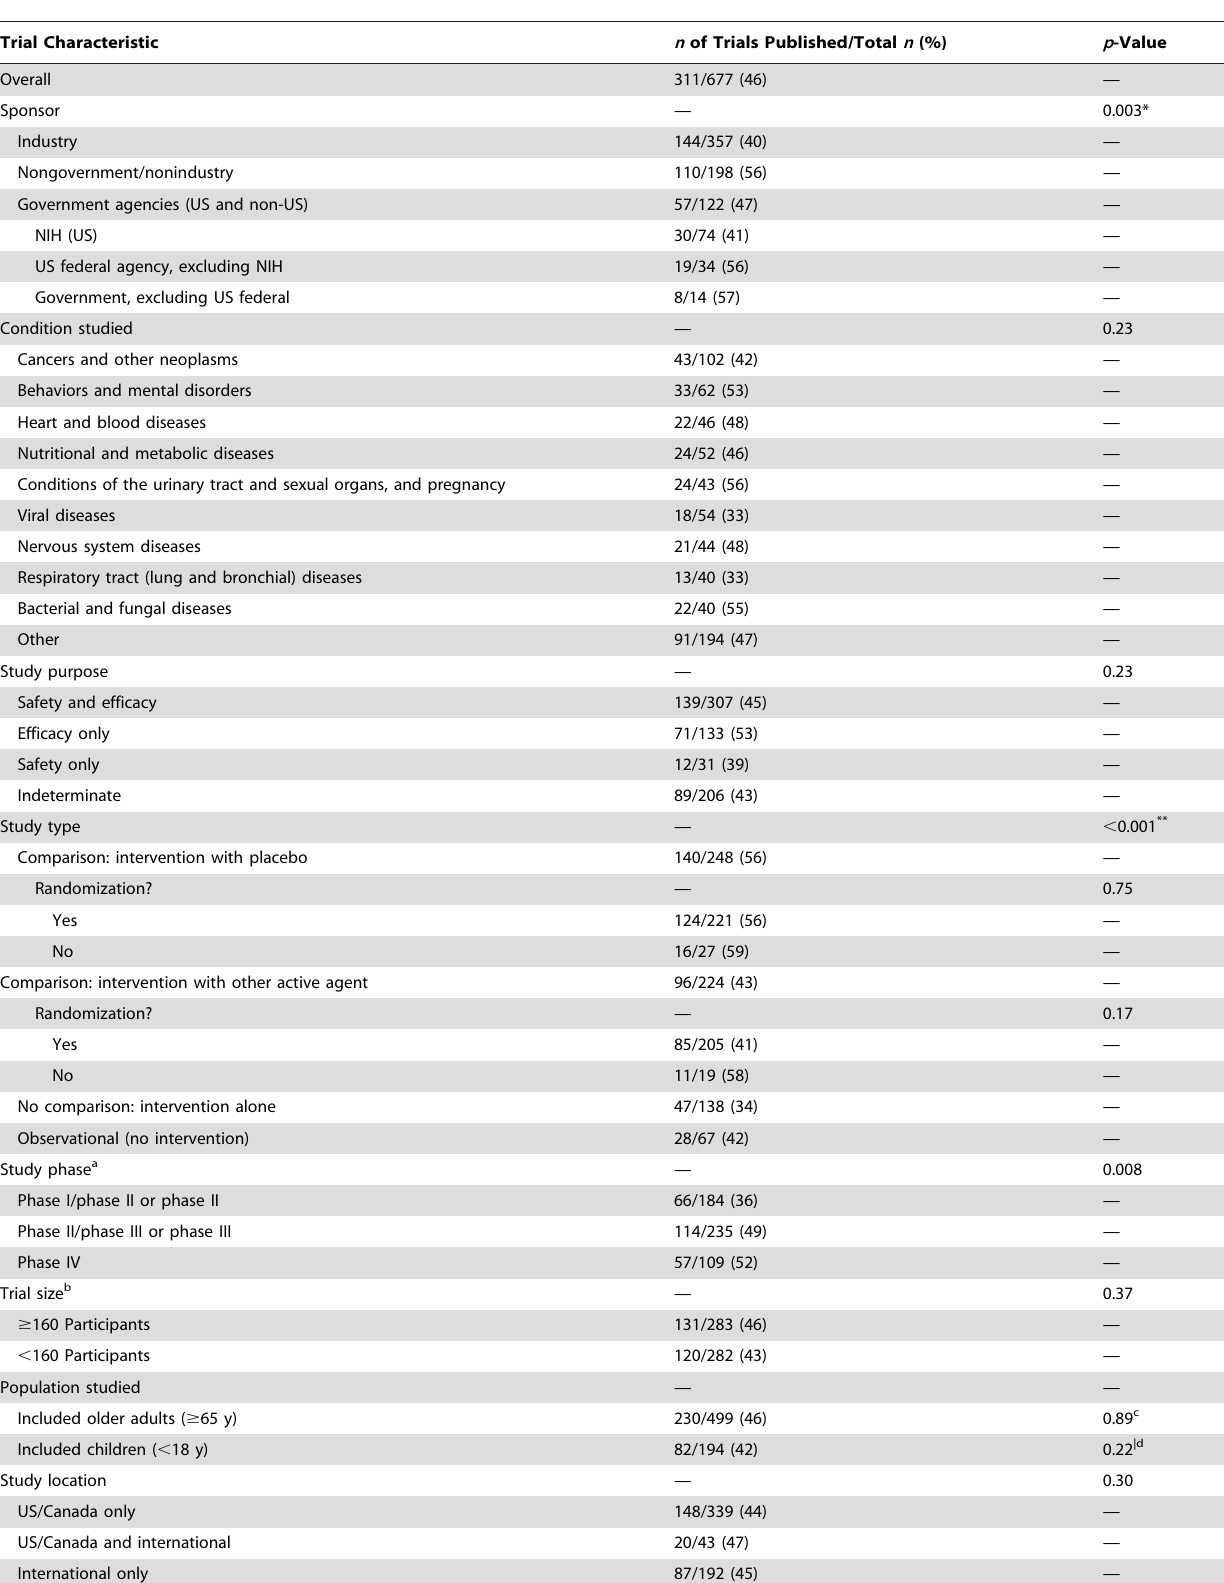
Table 2. Publication rates stratified by trial characteristics among a 10% random subsample of completed trials registered in the ClinicalTrials.gov